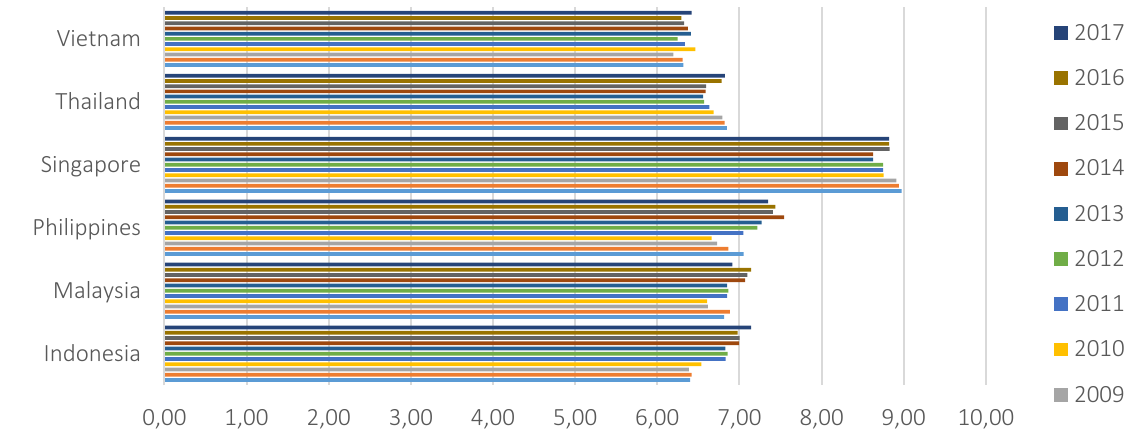
Figure 1. Economic Freedom Index